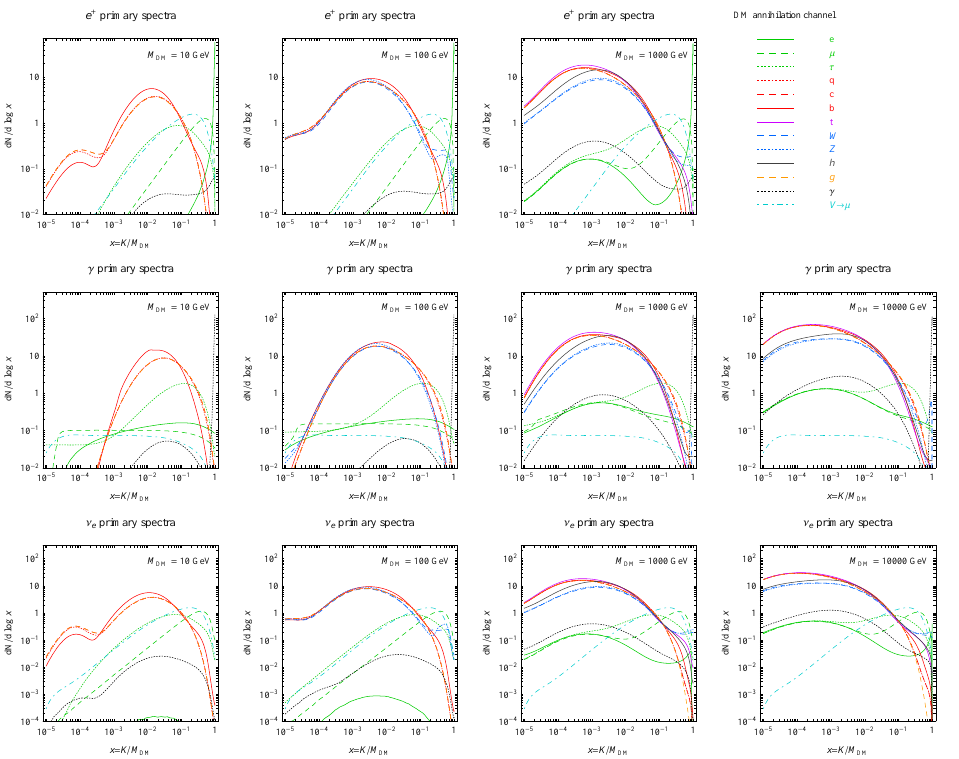
Figure 1: Primary fluxes of e + (top row), γ (middle row) and ν annihilation of DM with different masses, as a function of the particle (kinetic) energy K divided by the DM mass. Different final states correspond to differently-colored lines as indicated in the legend. Reproduced from Ref. [ 29 ] ; see that work for